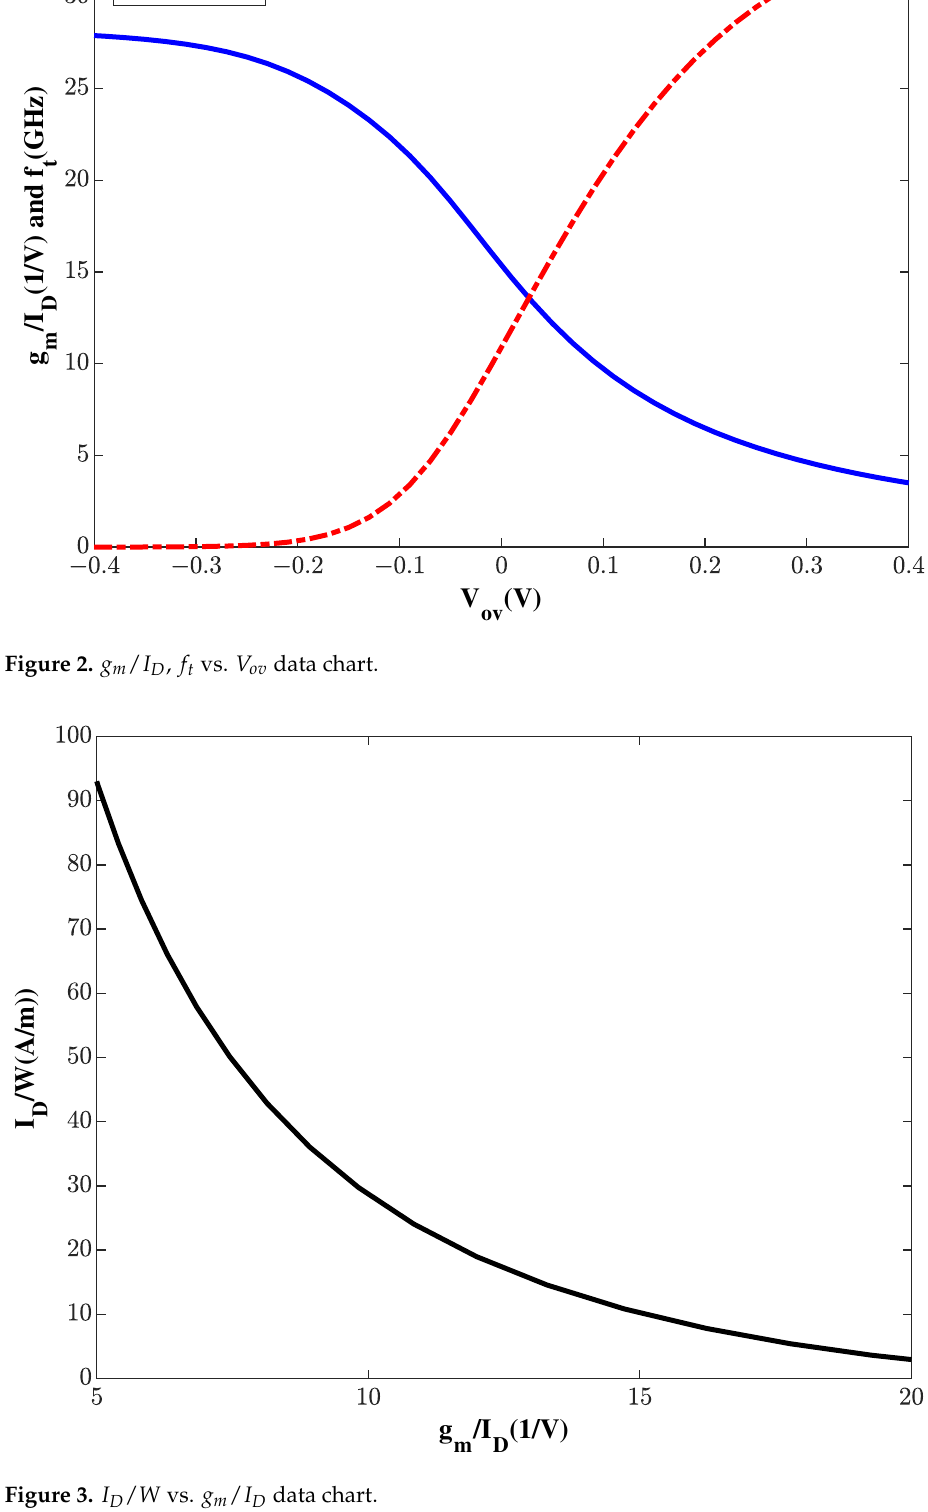
Figure 3. I D / W vs. g m / I D data